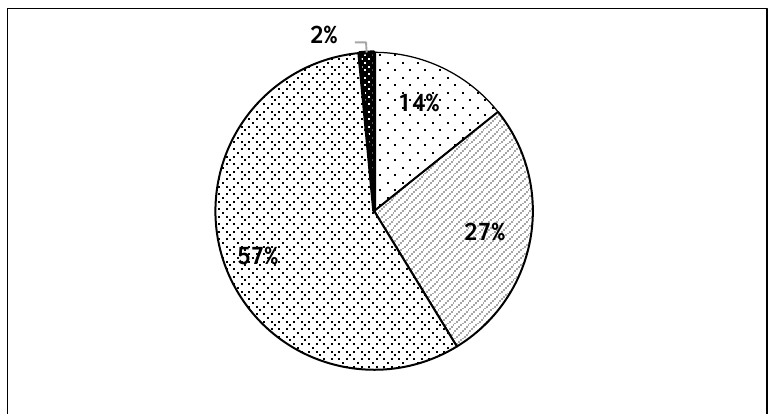
Figure 2: Percentage distribution of crash by severity